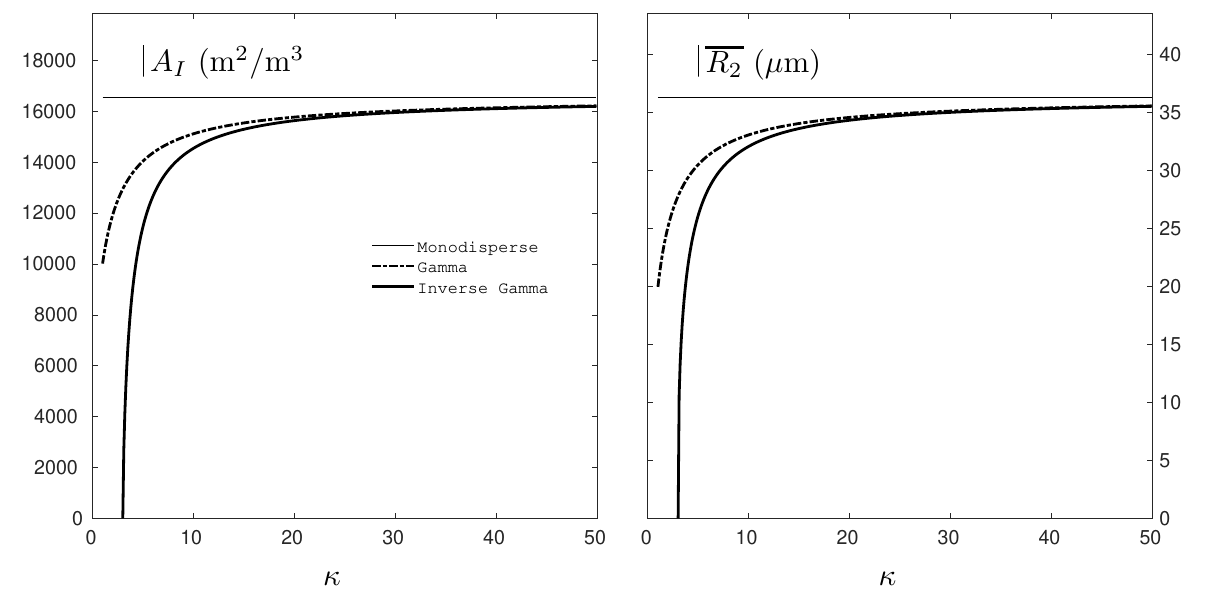
Figure 4: Comparison of the interfacial area A I and mean radius R 2 , in the monodisperse and polydisperse situations, for various κ parameters. The specific number of droplets N 2 and liquid volume fraction α 2 are constant and are set to N 2 = 10 12 droplets per unit volume and α 2 = 0.2. For the monodisperse situation, A I and R 2 are computed via Eq. (4.30). For the polydisperse situation, A I and R 2 are computed via Eq. (4.31).